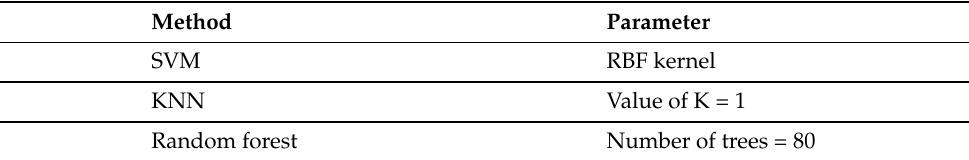
Table 6. Parameter configuration for classifier